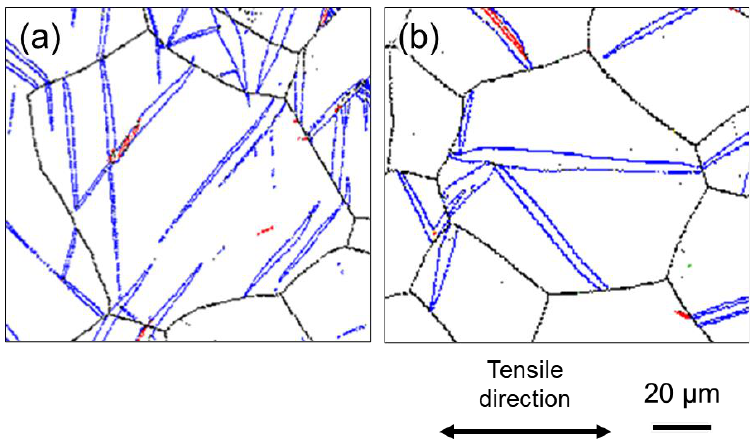
Figure 7. Enlarged GB maps for the areas enclosed by the black dashed circle in Figure 5a,d corre- sponding to ( a ) high strain rate (10 0 s −1 ) and ( b ) low strain rate (10 −6 s −1 ), respectively.